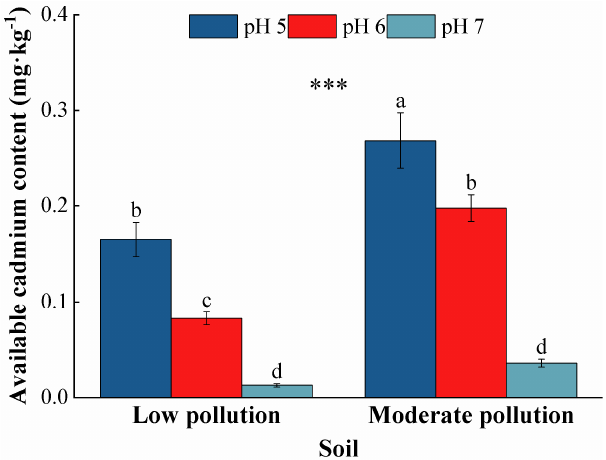
Figure 5. Effects of different treatments on the soil available cadmium (Cd) content after the plants were grown in the soil. Different lowercase letters indicate significant differences between different pH treatments (*** p < 0.001).